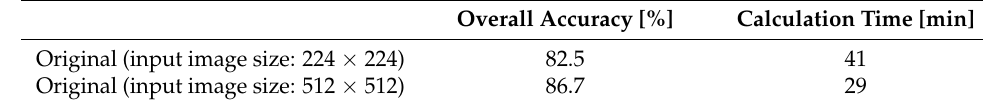
Table 1. Overall accuracies and calculation times of the original AlexNet.